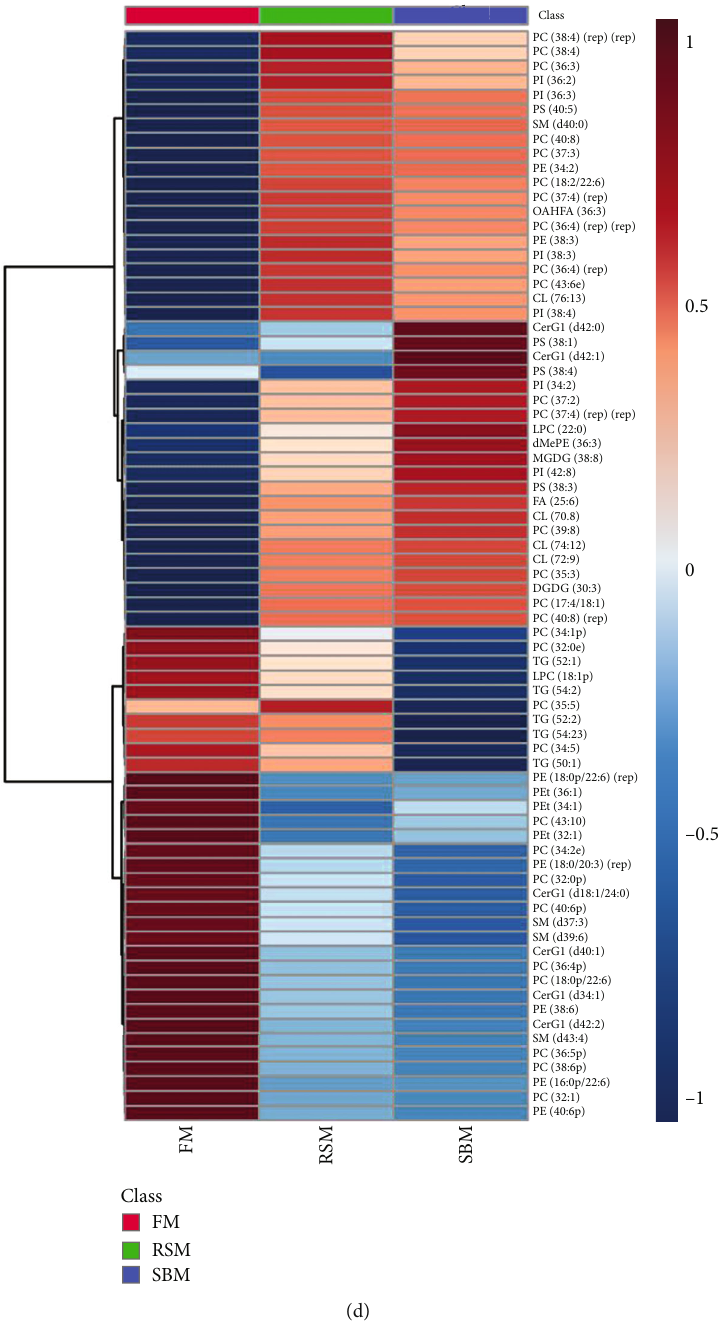
Figure 4: E ff ect of di ff erent dietary protein sources on hepatic lipid metabolites of female yellow cat fi sh broodstock based on the lipidomics approach. (a). Analysis of mean peak intensity of main class lipid molecules; values are expressed as means ± SE ( n = 6 ); di ff erent letters represent the statistically signi fi cant di ff erences ( P < 0 : 05 ). (b). PLS-DA discriminant analysis model score map. (c). Volcano plots of all identi fi ed lipid metabolites from lipidomics; di ff erent colors were used to represent downregulated (blue), upregulated (red), or nonsigni fi cant (gray) metabolites.(d). Heatmap of di ff erential subclass lipid molecules. Z score normalized ionic strength for each metabolite was represented by di ff erent colors: high (red), low (blue), or average